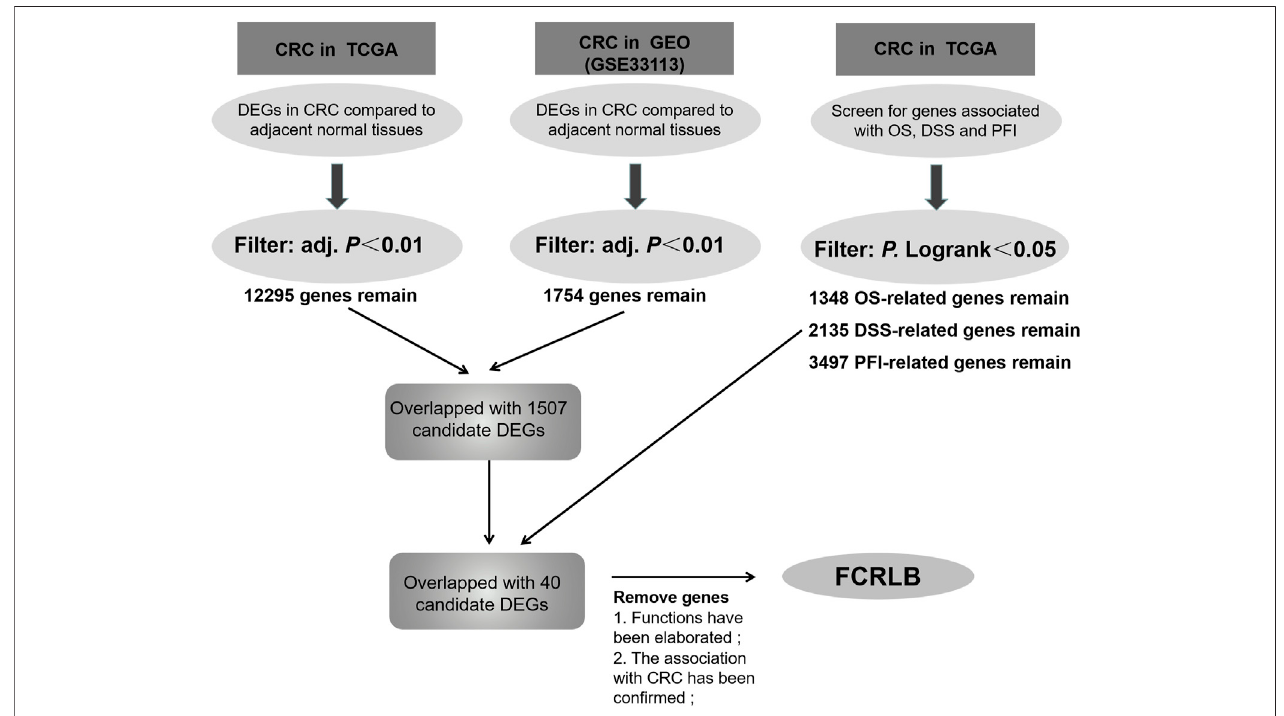
FIGURE 1 | The screening fl ow chart for selected DEGs associated with prognosis of CRC